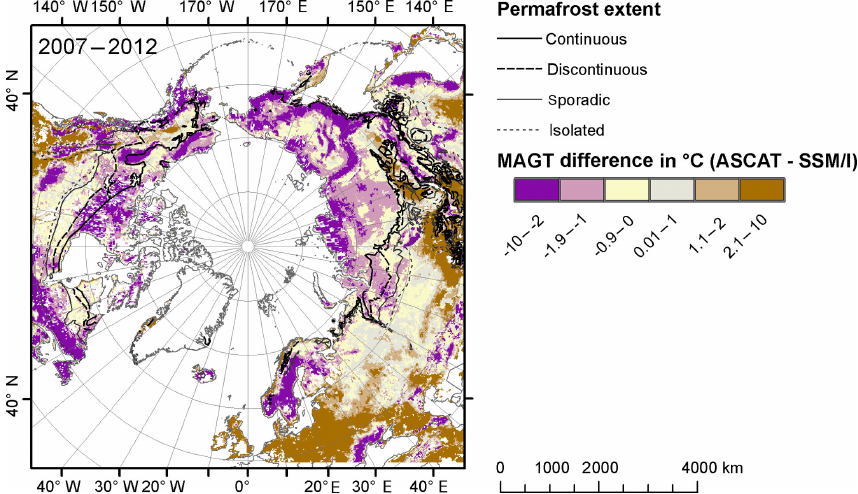
Figure 4. Comparison of MAGT c (coldest sensor) in degrees Celsius of all years between Metop ASCAT (FT) and SSM/I for 2007–2012. Source of permafrost extent classes is Brown et al. (1997).